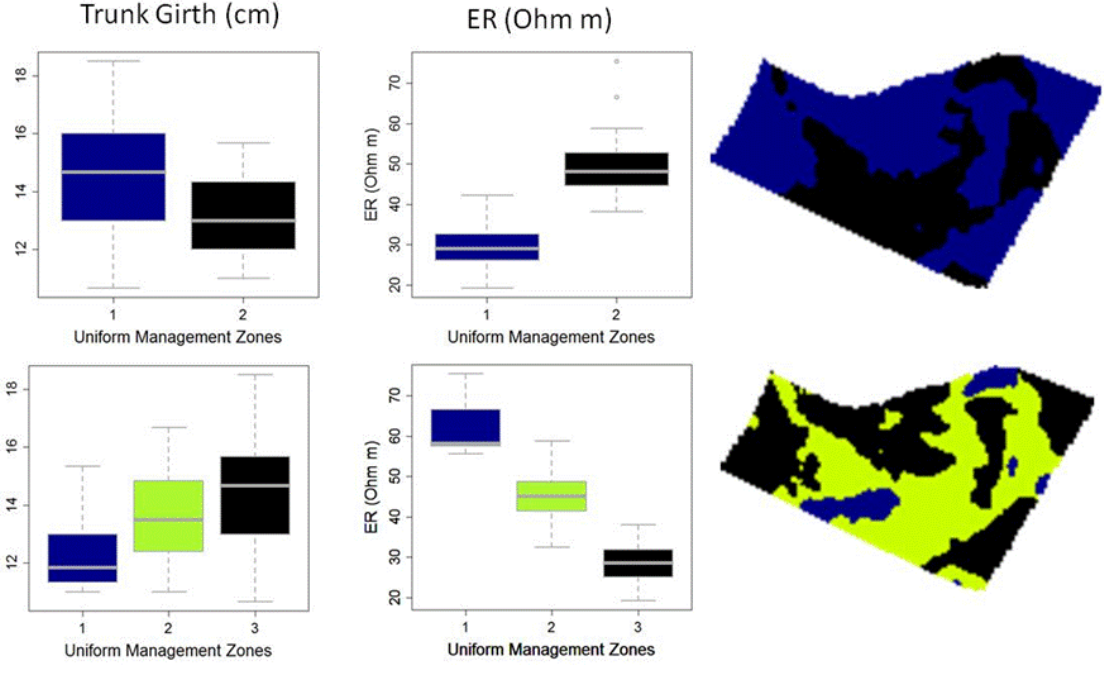
Figure 8. Boxplots of trunk girth and ER with increasing number of clusters ( left ) and uniform management zones maps derived by the clustering analysis ( right ). Top: management zone 1: blue; management zone 2: black. Bottom: management zone 1: blue; management zone 2: green; management zone 3: